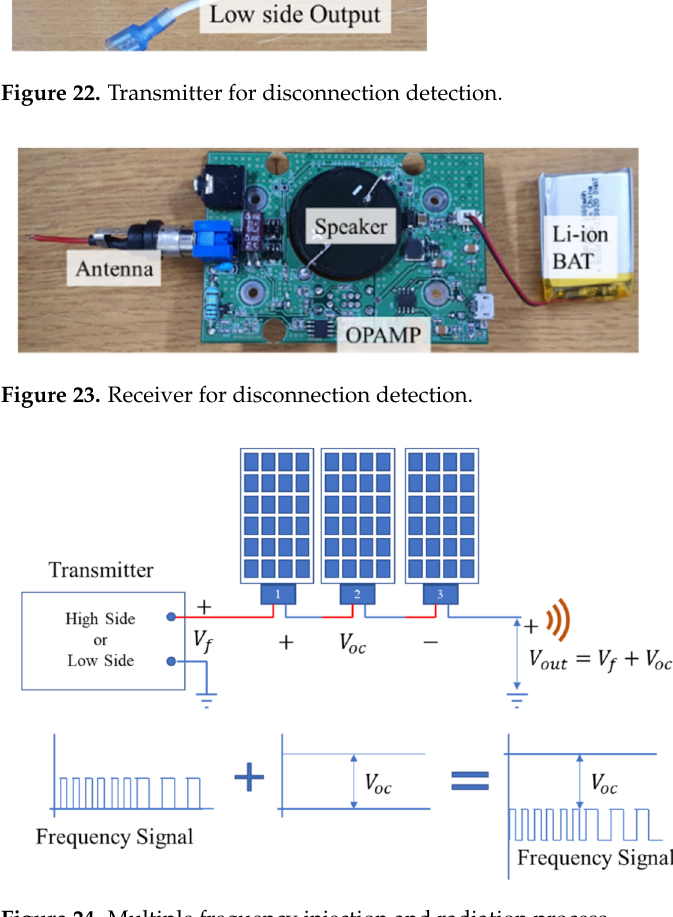
Figure 24. Multiple frequency injection and radiation